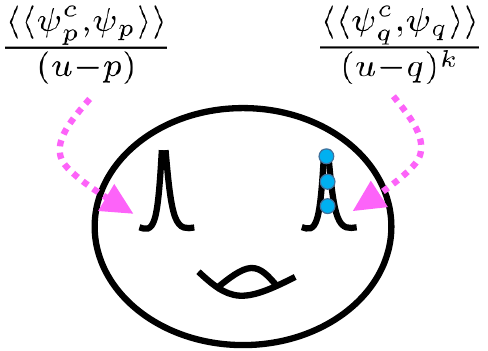
Figure 1 . Depiction of a Hitchin system on a genus one curve with poles at marked points indicated by narrow cylindrical regions, that is, spikes. Background values for localized matter (cid:12)elds induce poles in the Higgs (cid:12)eld of the Hitchin system. On the left we depict matter localized at u = p which generates a simple pole. On the right we depict matter localized at the non-reduced scheme ( u (cid:0) q ) k = 0 which generates a higher order